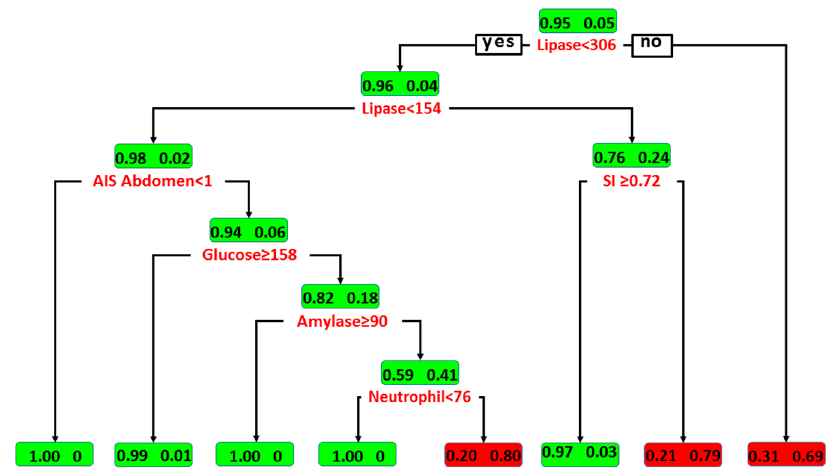
Figure 1. Illustration of DT model for predicting pancreatic injury in patients with elevated serum amylase or lipase levels. Boxes denote the percentage of patients with discriminating variables from CART analysis. Patients with and without pancreatic injury are indicated by the fractional number inside the right and left sides of the boxes, respectively.